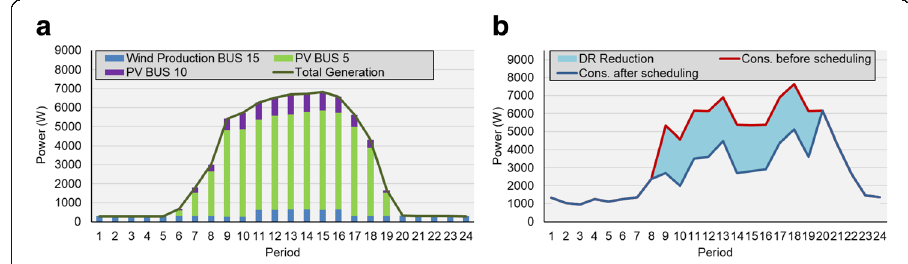
Fig. 7 Optimization results for CSP resource scheduling: a generation scheduling for BUS #15, #10, and #5; b consumption scheduling for BUS